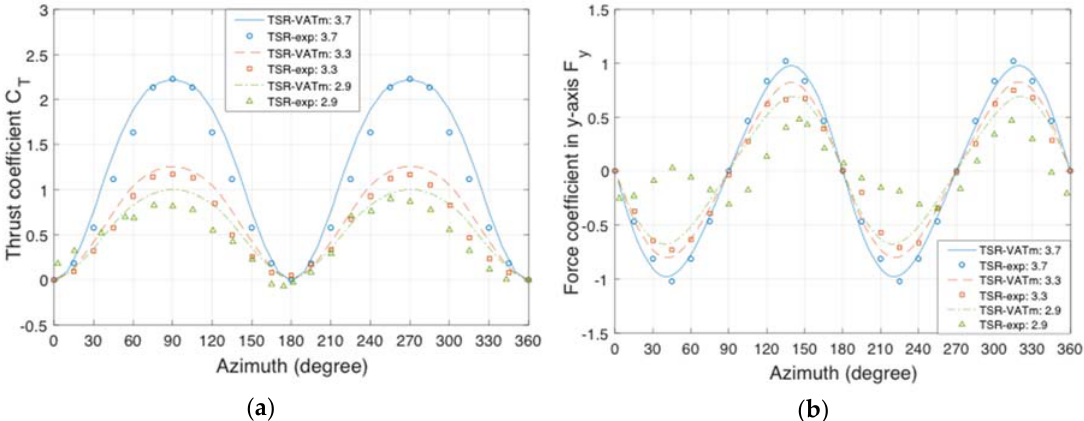
Figure 7. Comparison between predicted and measured [70] thrust and lateral force coe ffi cients for di ff erent values of tip-speed ratio (TSR) (2.9, 3.3, and 3.7 ) as functions of azimuthal angle: ( a ) Thrust coe ffi cient C T ; and ( b ) Lateral force coe ffi cient F y .